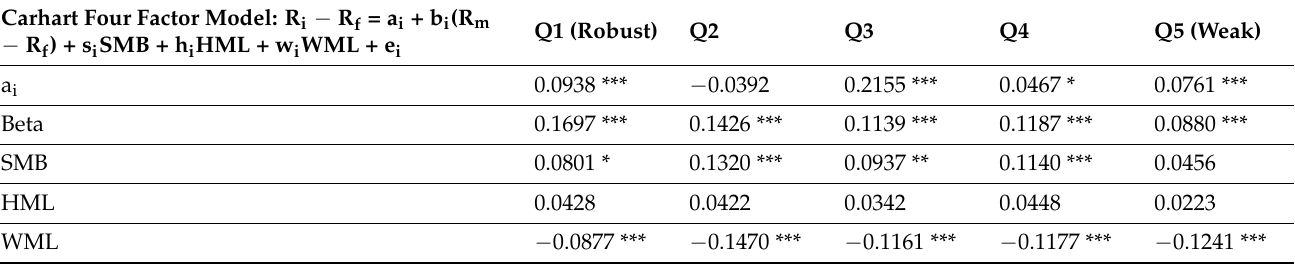
Table 9. Robustness check for Robust and Weak Profitability REIT portfolios (2001–2020).